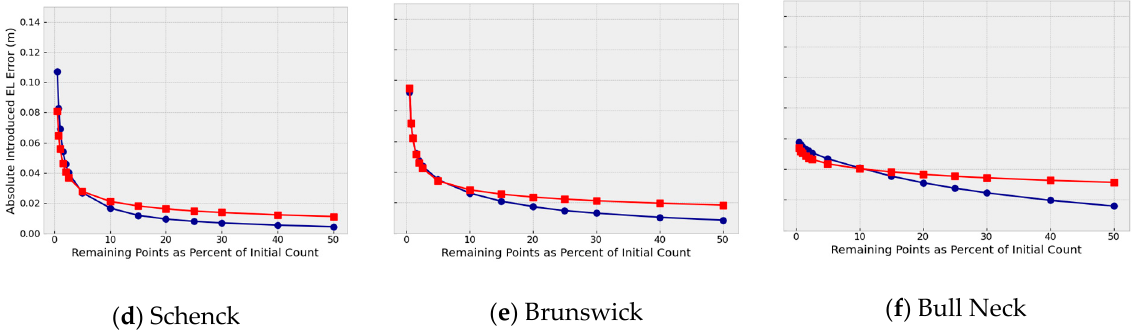
Figure 10. Absolute elevation error values for Curvature Weighted Decimation (open symbols) at a 50/50 method split compared with Random Decimation (filed symbols) for the six study test areas.